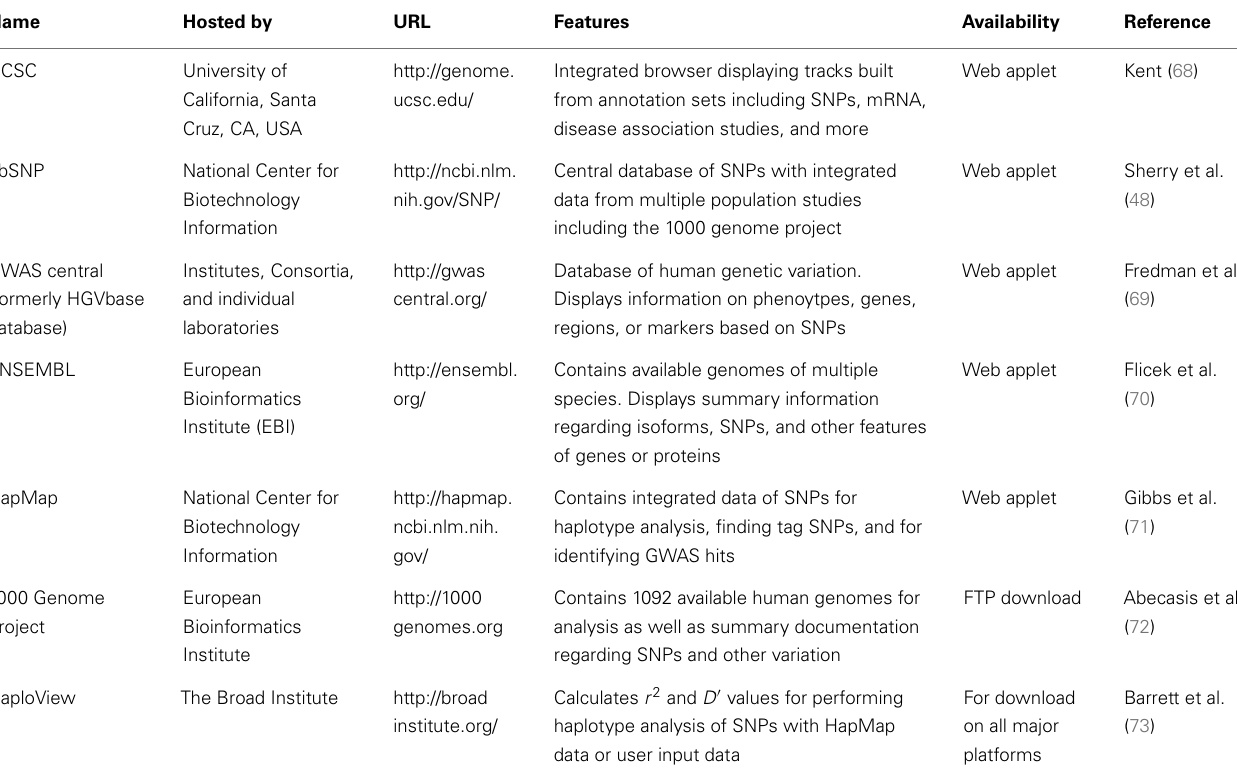
Table 5 | Publicly available single-nucleotide polymorphism (SNP) databases